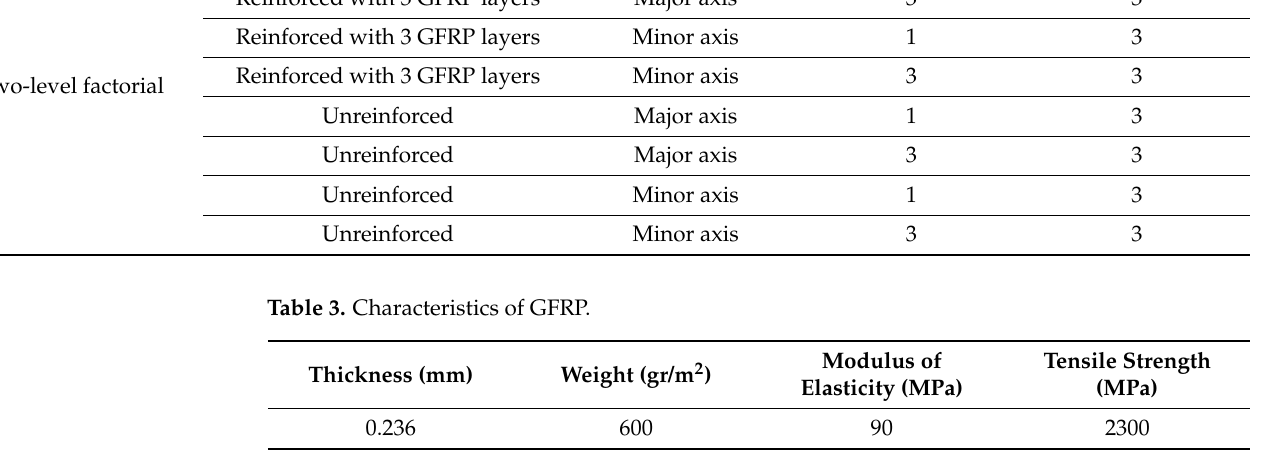
Figure 2. Placement of metal connector and fastener in CLT specimens. Table 4. Properties of lag screw (8 mm) Table 4. Properties of lag screw (8 mm) [36].